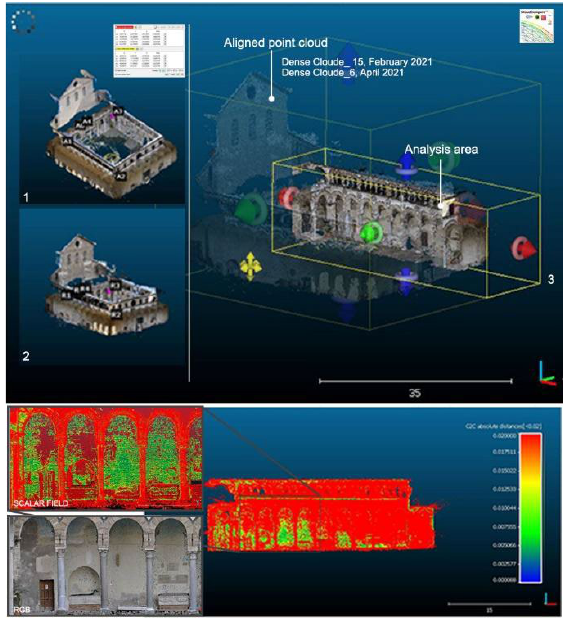
Figure 7. The integration of data and distance values (C2C cloud to cloud)